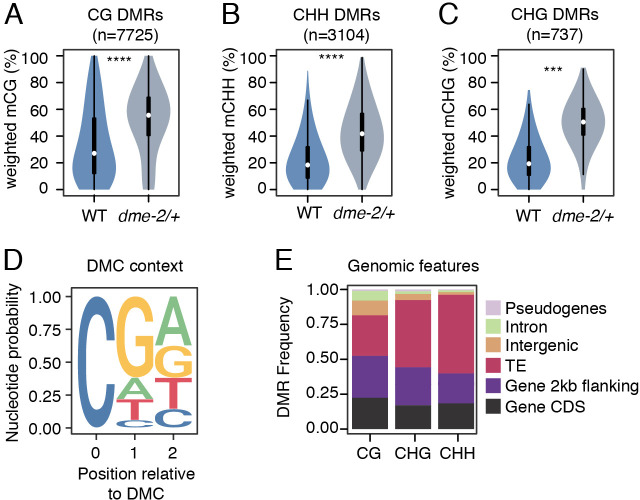
Differential methylated region (DMR) analysis between VN from wild-type (WT) and dme-2/+ mutant pollen.(A–C) Violin plots showing weighted DNA methylation rates of DMRs in CG (A), CHH (B), and CHG (C) context. Each overlaid boxplot indicates minimum and maximum values as well as 25th, 50th, and 75th quartiles. p-values <2.2e-16 and <1.6e-4 based on Mann–Whitney U-test of methylation differences between WT and dme-2/+ are represented by **** and *** respectively. (D) Nucleotide probability of significant differentially methylated cytosines (DMCs) within DMRs in VN from dme-2/+ pollen compared to WT. (E) Proportion of genomic features overlapping CG, CHG, and CHH DMRs.